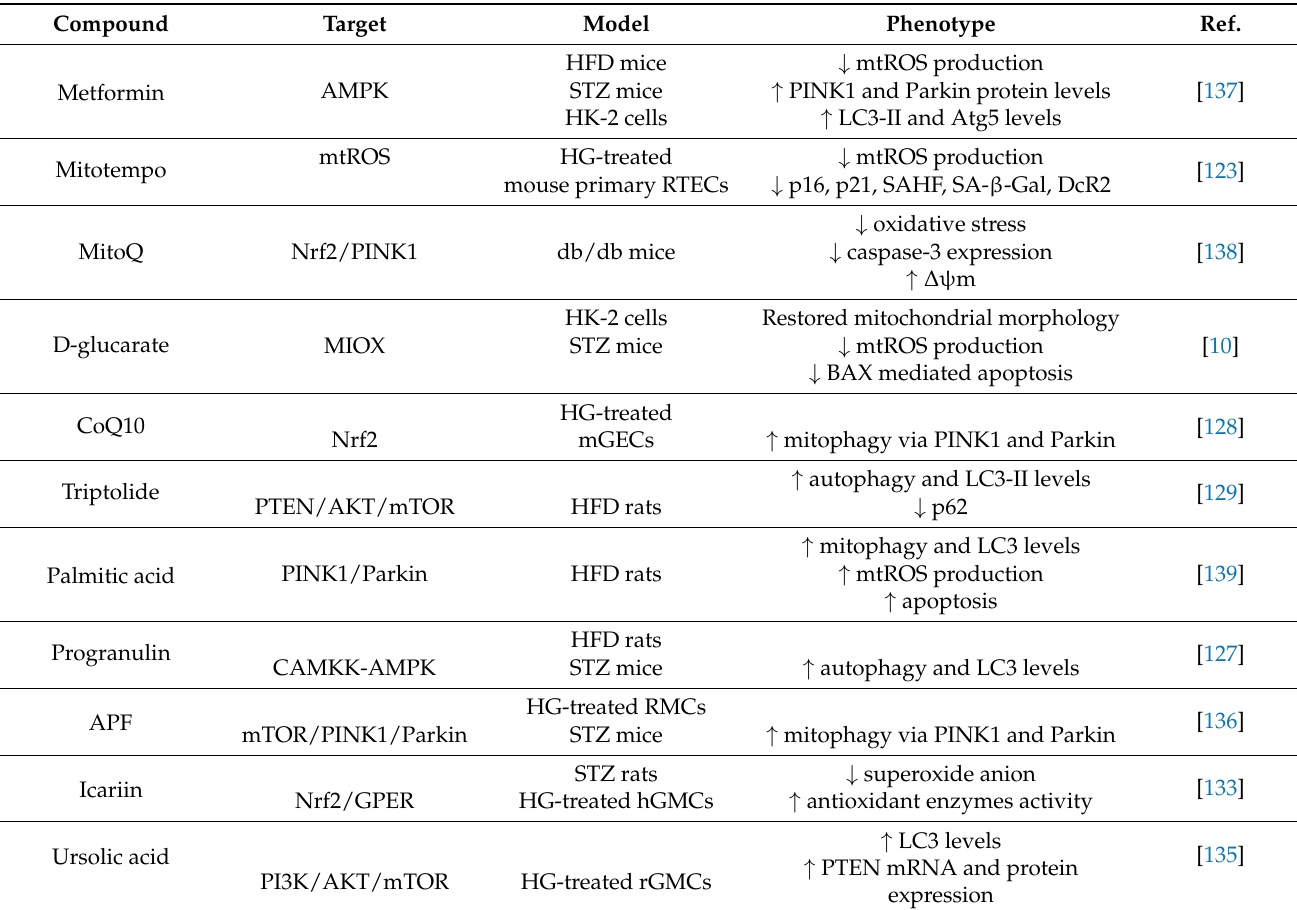
Table 1. Mitophagy modulators in experimental models of